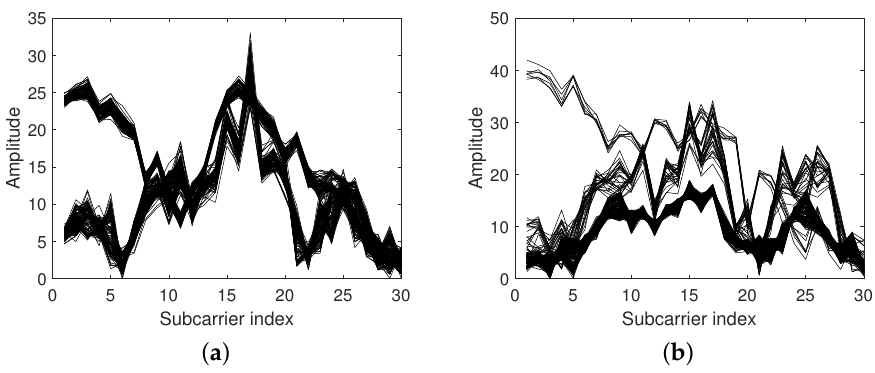
The details of DBSCAN are shown in Algorithm 1.